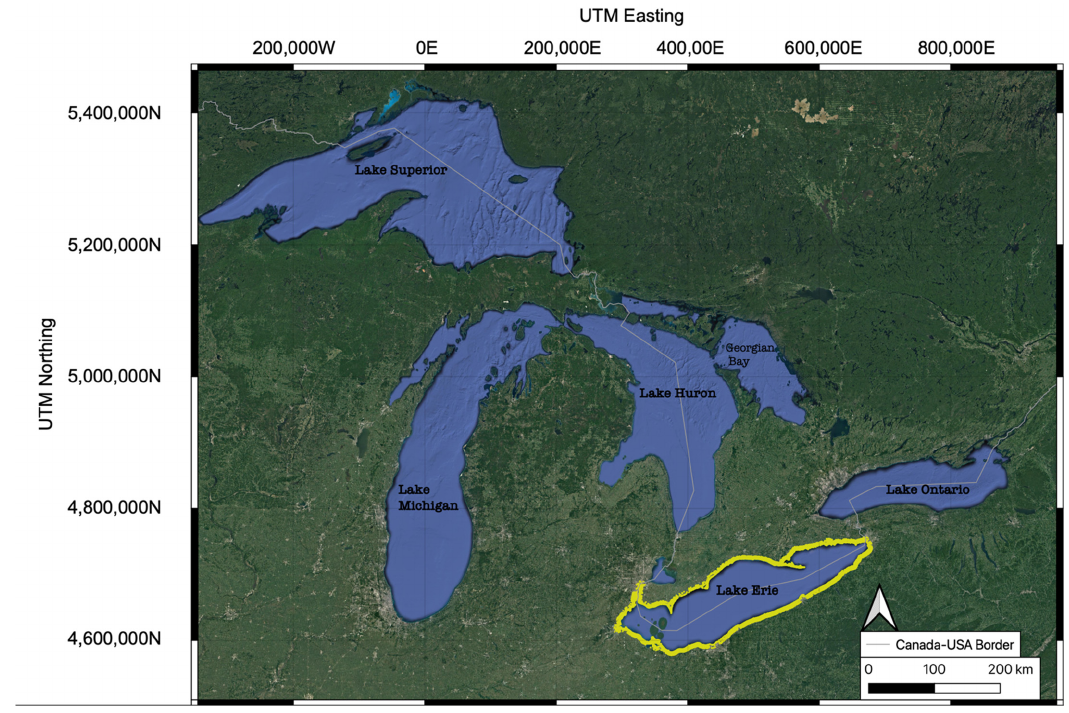
Figure 1. The Great Lakes Region (satellite image from Google Maps). Lake Erie is highlighted with a yellow band.